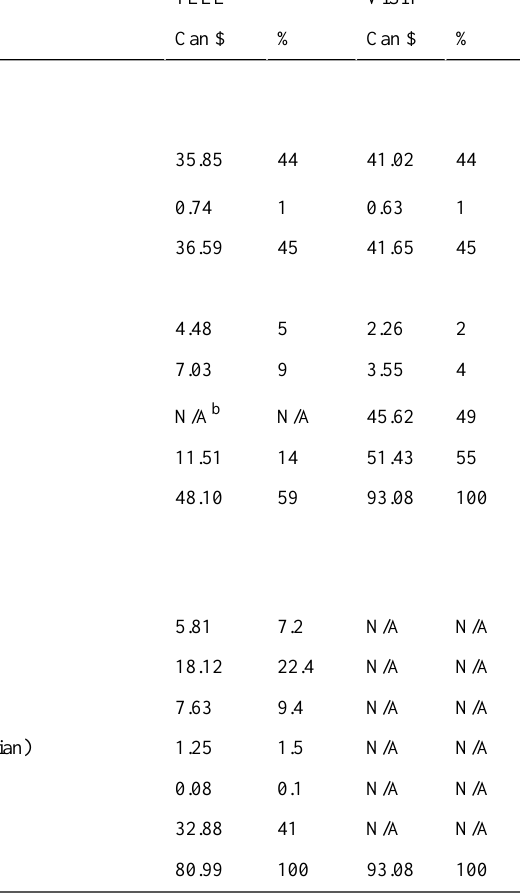
Table 5. Cost sensitivity analysis based on round-trip distance from health care center to patient’s home in the total sample (n=197).